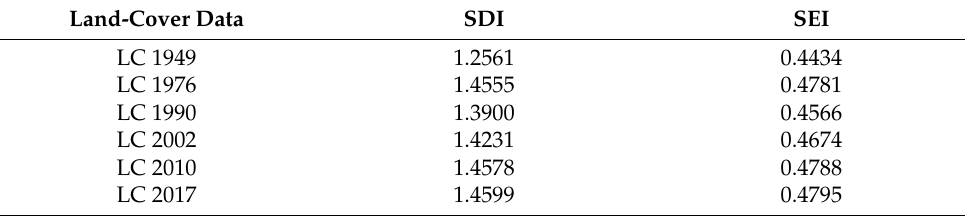
Table 6. Landscape metrics—Shannon Diversity Index (SDI) and Shannon’s Evenness Index